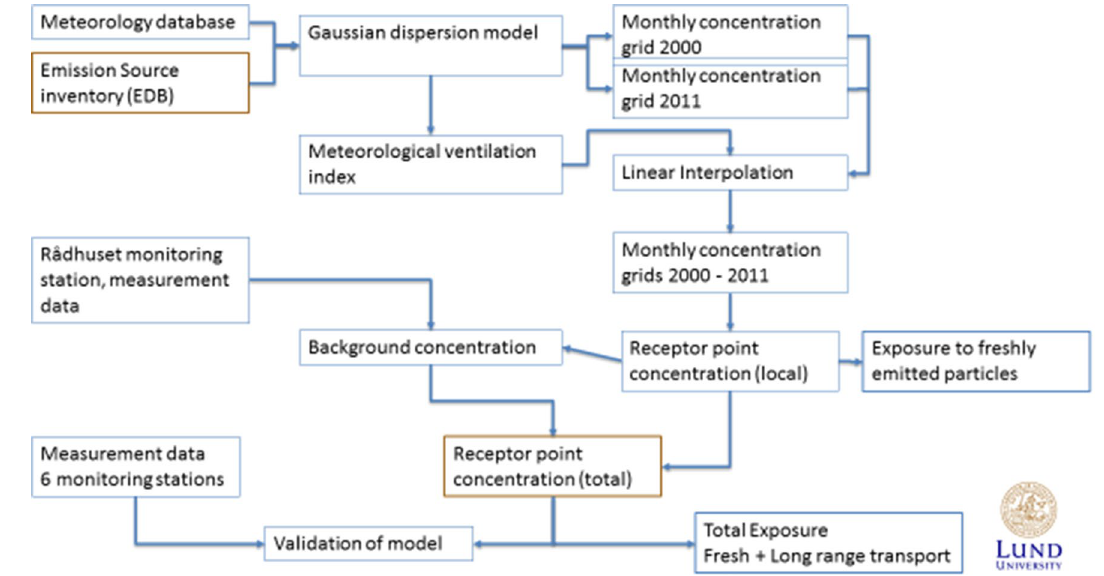
Fig. 2 Schematic representation of the modelling